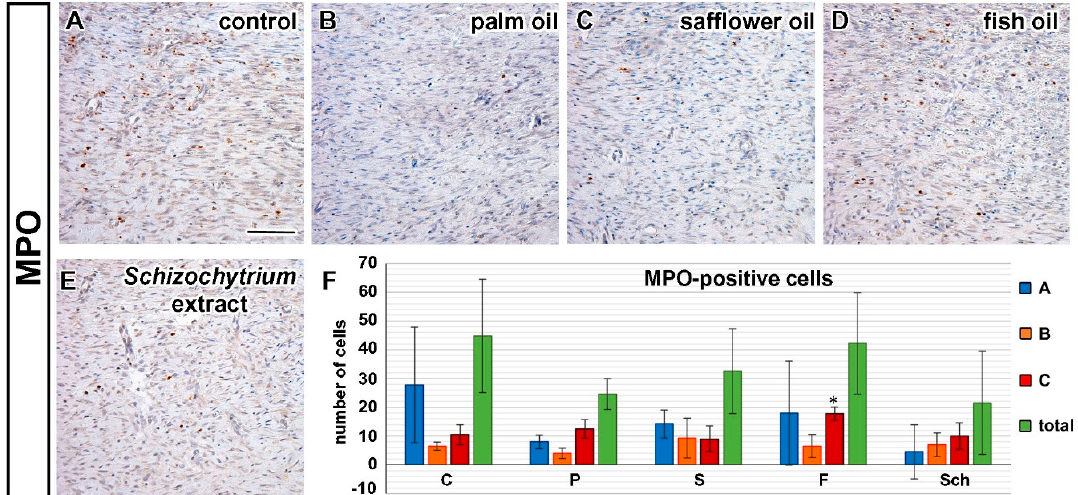
Figure 6. Detection of MPO-positive cells detected by immunohistochemistry. Control (C), palm oil (P), safflower oil (S), fish oil (F), and Schizochytrium extract (Sch) treated animals were analyzed 12 days after skin excision. ( A – E ): Photos were taken in the middle (“B”) layer (see for explanation Figure 14C); ( F ): Number of MPO-positive cells in the superficial layer (A, blue), in the middle (B, orange) and in the deep layer of the dermis (C, red). Sum of positive cells (green, total). Average values and standard deviations are displayed in the graph. (* p < 0.05; unpaired t -test; n = 5). Scale bar = 100 µ